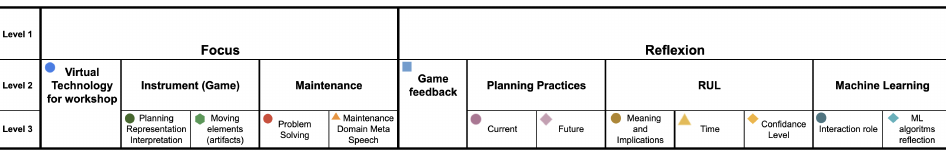
Figure 4. Taxonomy of coded conversation